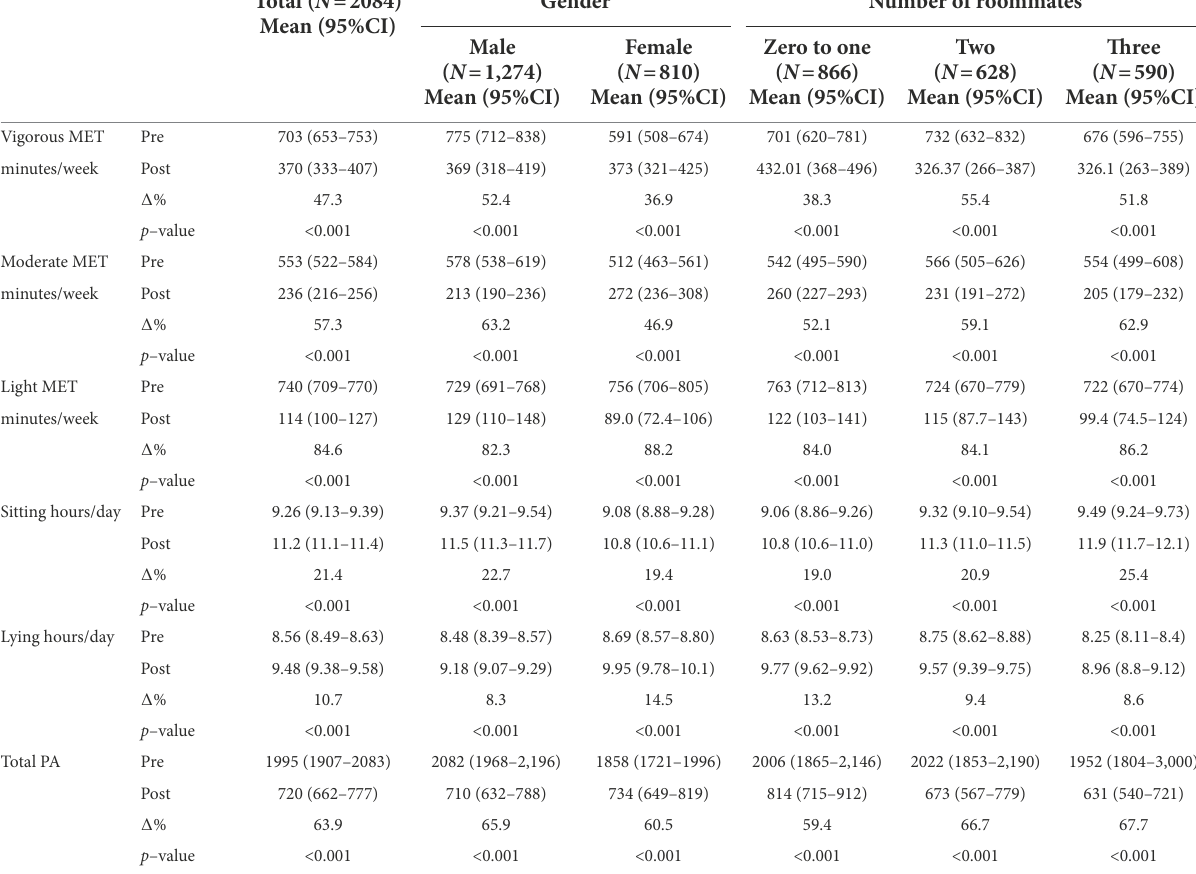
TABLE 2 Changes in physical activity